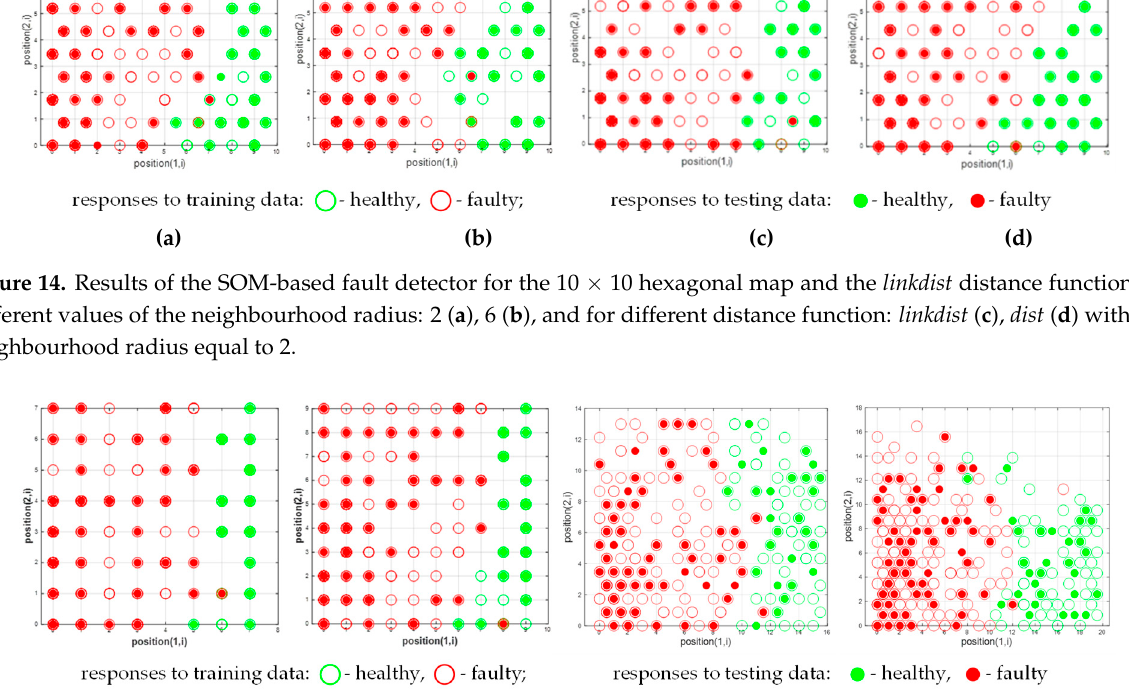
Figure 15. Results of the SOM-based fault detector for various sizes of the hexagonal map 8 × 8 ( a ), 10 × 10 ( b ), 16 × 16 ( c ), 20 × 20 ( d ) with the neighbourhood radius equal 2 and the linkdist function.